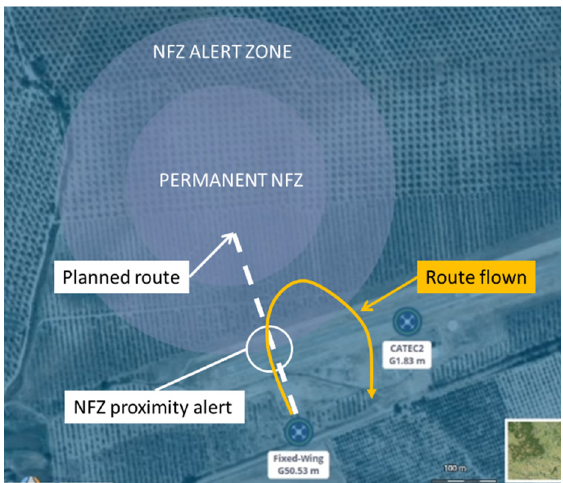
Figure 8. NFZ alert distance scenario showing the key elements.